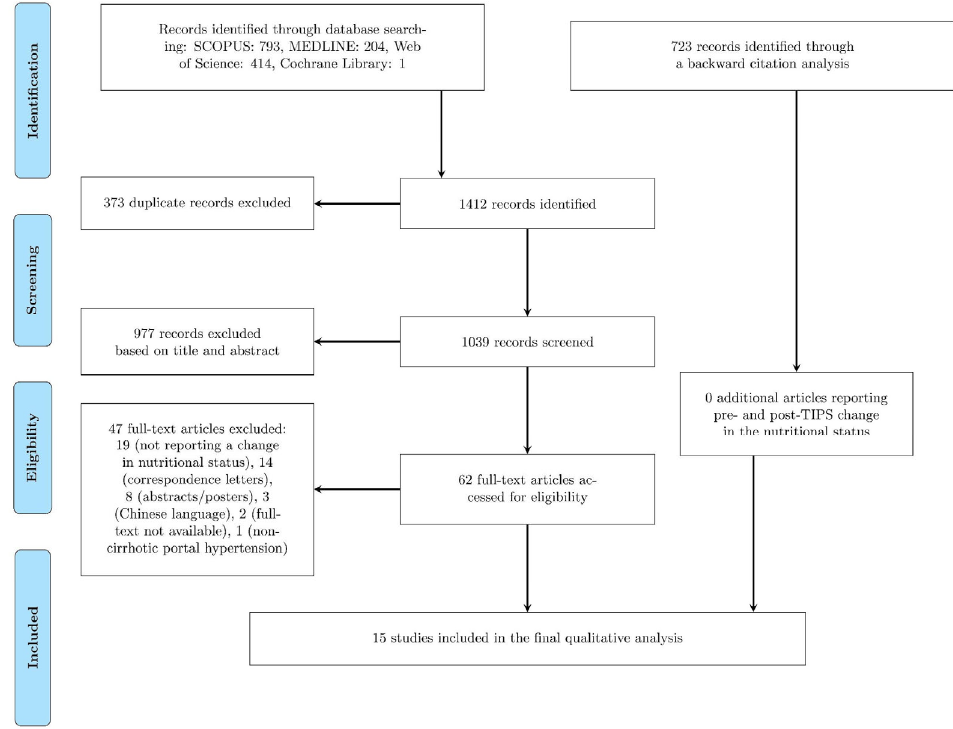
Figure 1. Flow of information through di ff erent phases of the systematic review.